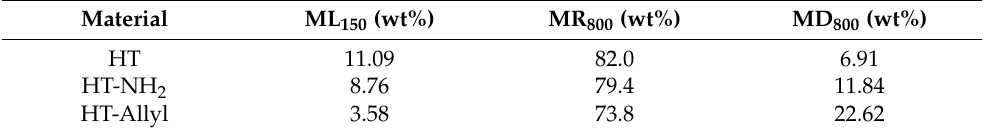
Table 1. Thermogravimetric parameters for HT, HT-NH 2 , and